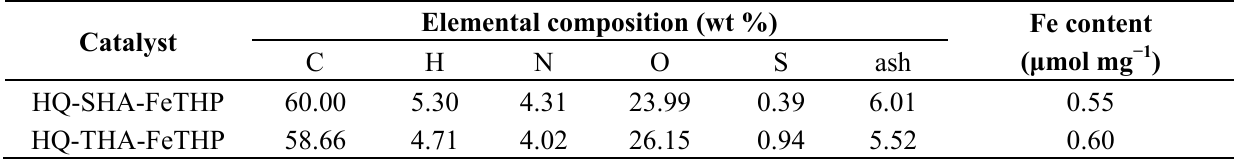
Table 1. Elemental composition and iron content of the synthesized HQ-HA-FHP catalysts.